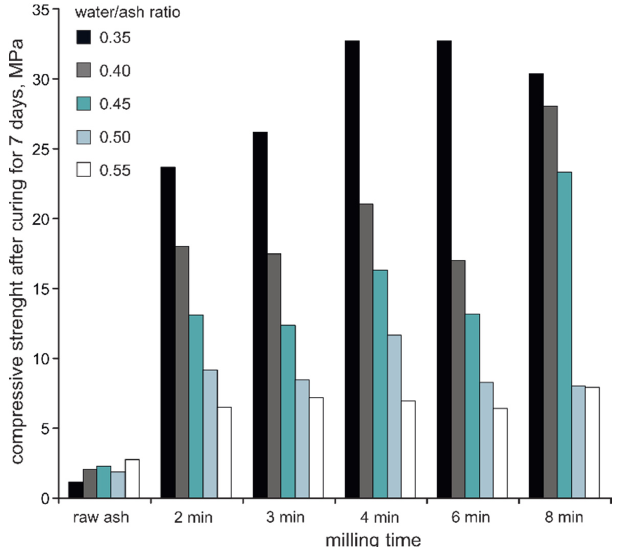
Figure 5. Uniaxial compressive strength of the ash pastes of raw ash mixtures and pastes made with milled ash for 2, 3, 4, 6, and 8 min mixed at different water/ash ratios (0.35, 0.4, 0.45, 0.5, and 0.55) and cured for 7 days. Note a significant drop in compressive strength in the pastes with activated ash at higher water/ash ratios.